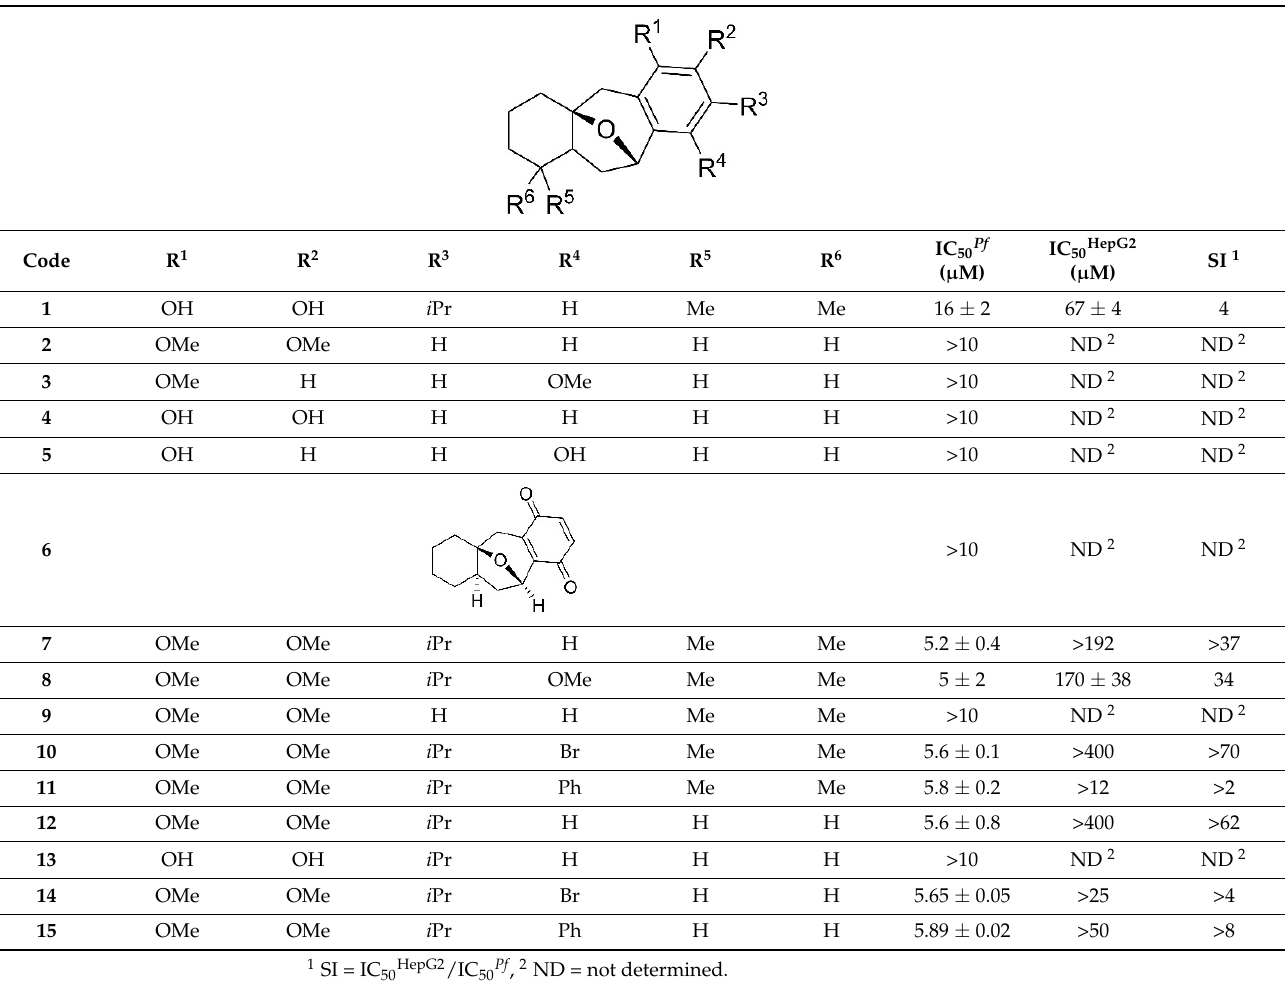
Table 1. In vitro antiplasmodial activity, cytotoxicity, and SI of brussonol and its derivatives.